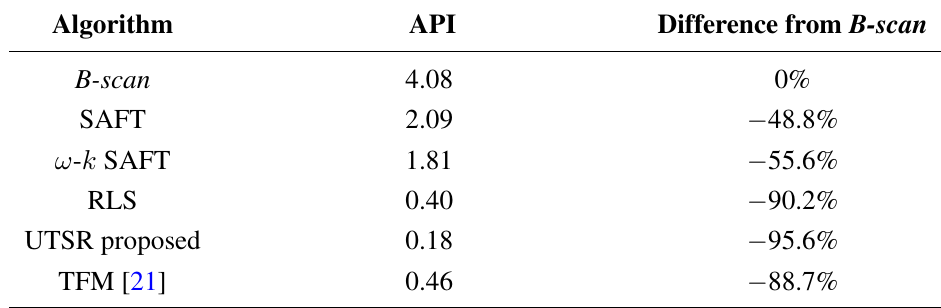
Table 1. API for images reconstructed from simulated data. Point-like reflector at z = 40